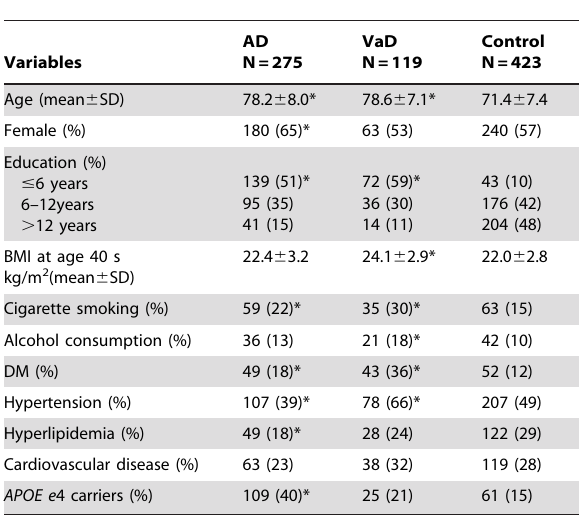
Table 1. Characteristics of the study